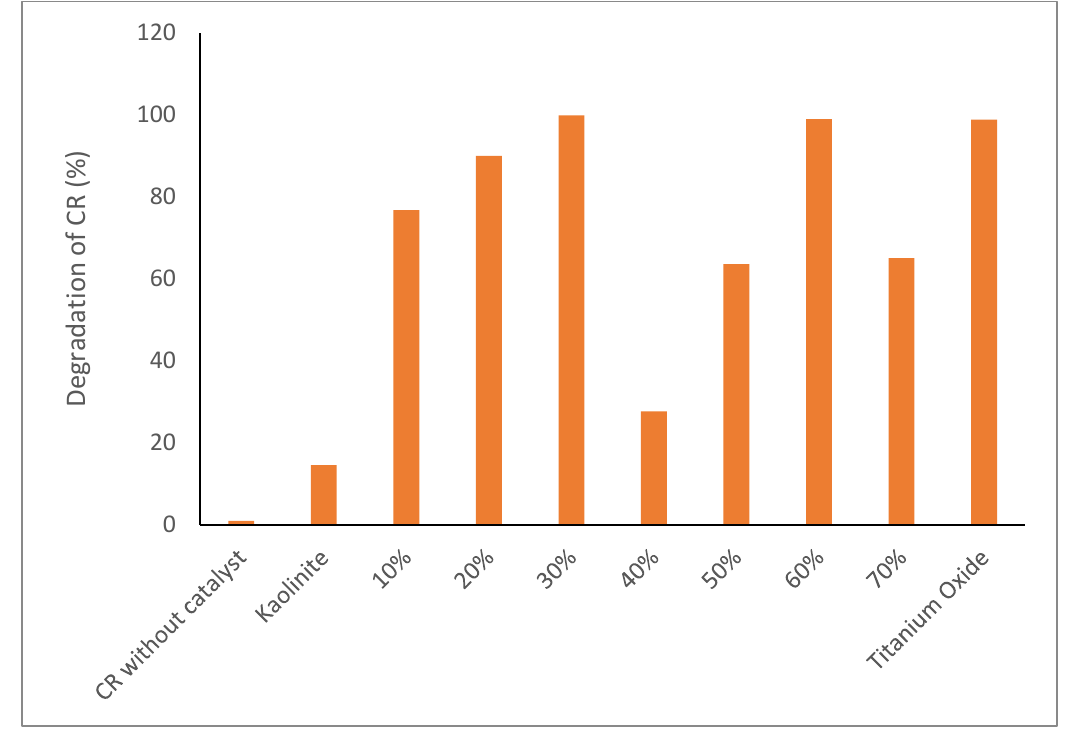
Figure 5. Photocatalytic degradation of CR in the kaolinite and in TiO 2 –JK. The degradation percentage for CR under dark conditions with continuous stirring ranged for the different ratios between 2 and 10%, proving the photodegradation process noticeably impacted absorption (Figure 6).